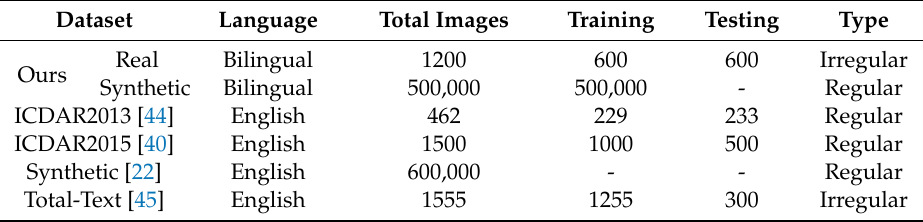
Figure 3. Sample of collected real scene text images. Table 2. Statistics of datasets applied for training and testing the proposed model.